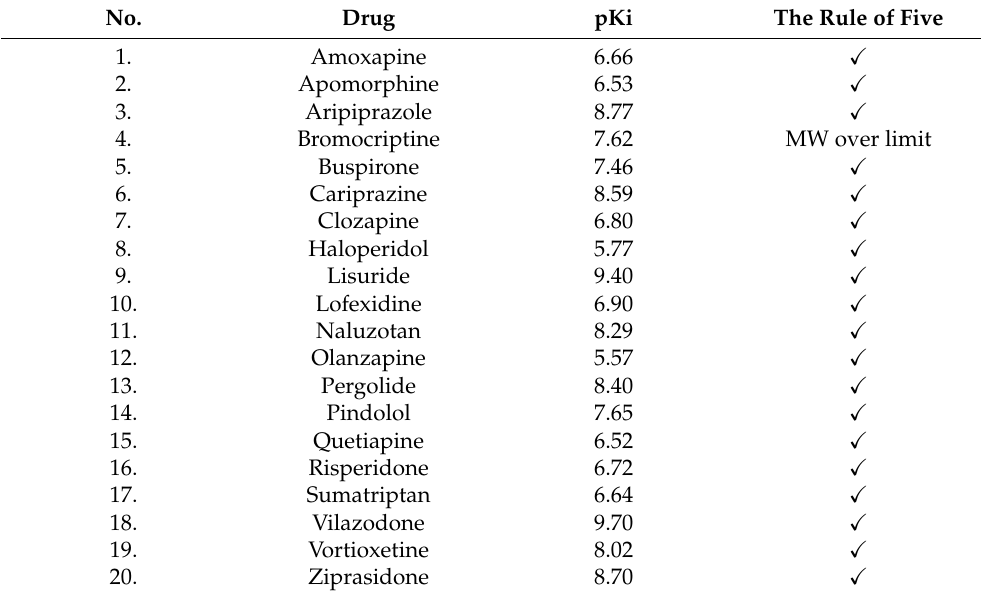
Table 2. Examples of approved drugs present in the curated